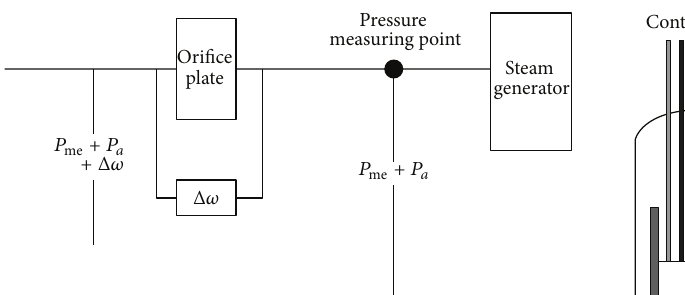
Figure 3: Pressure measuring schematic by orifice plate.